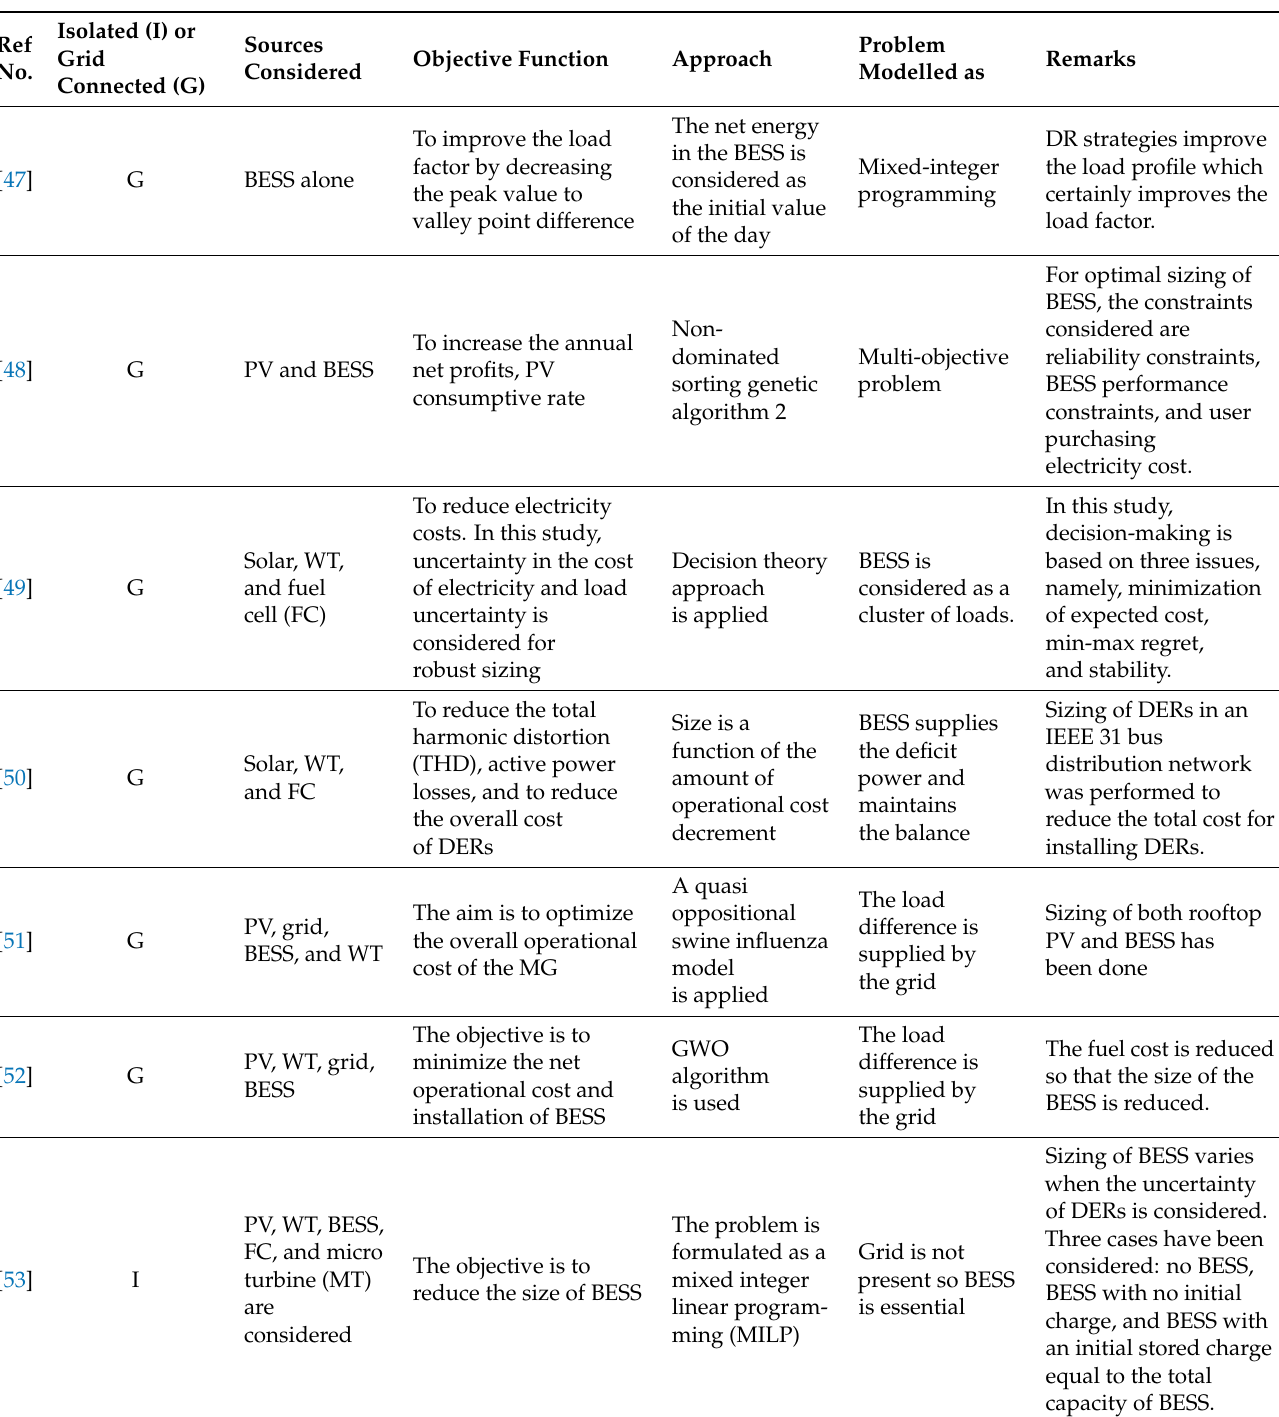
Table 3. BESS sizing for achieving EM in a